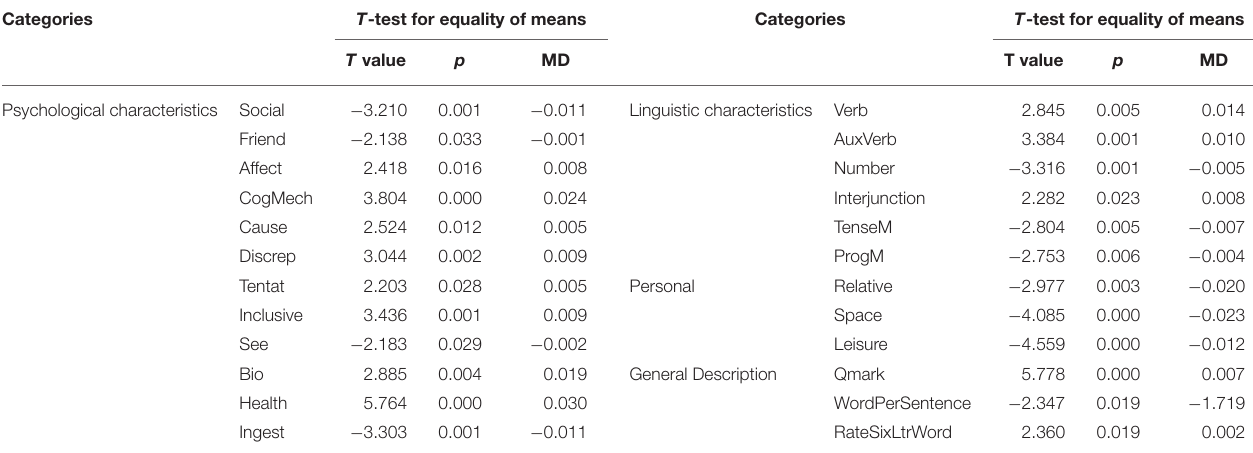
TABLE 2 | T -test results for truth and